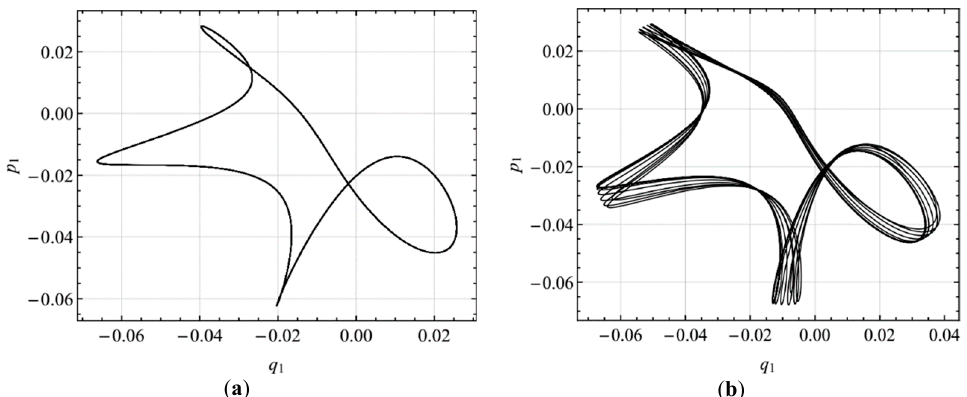
Figure 13. Two-dimensional projections of the phase portraits onto the p 1 – q 1 plane when σ 2 is between the Hopf bifurcation points; ( a ) σ 2 = -0.0315, ( b ) σ 2 = 0.